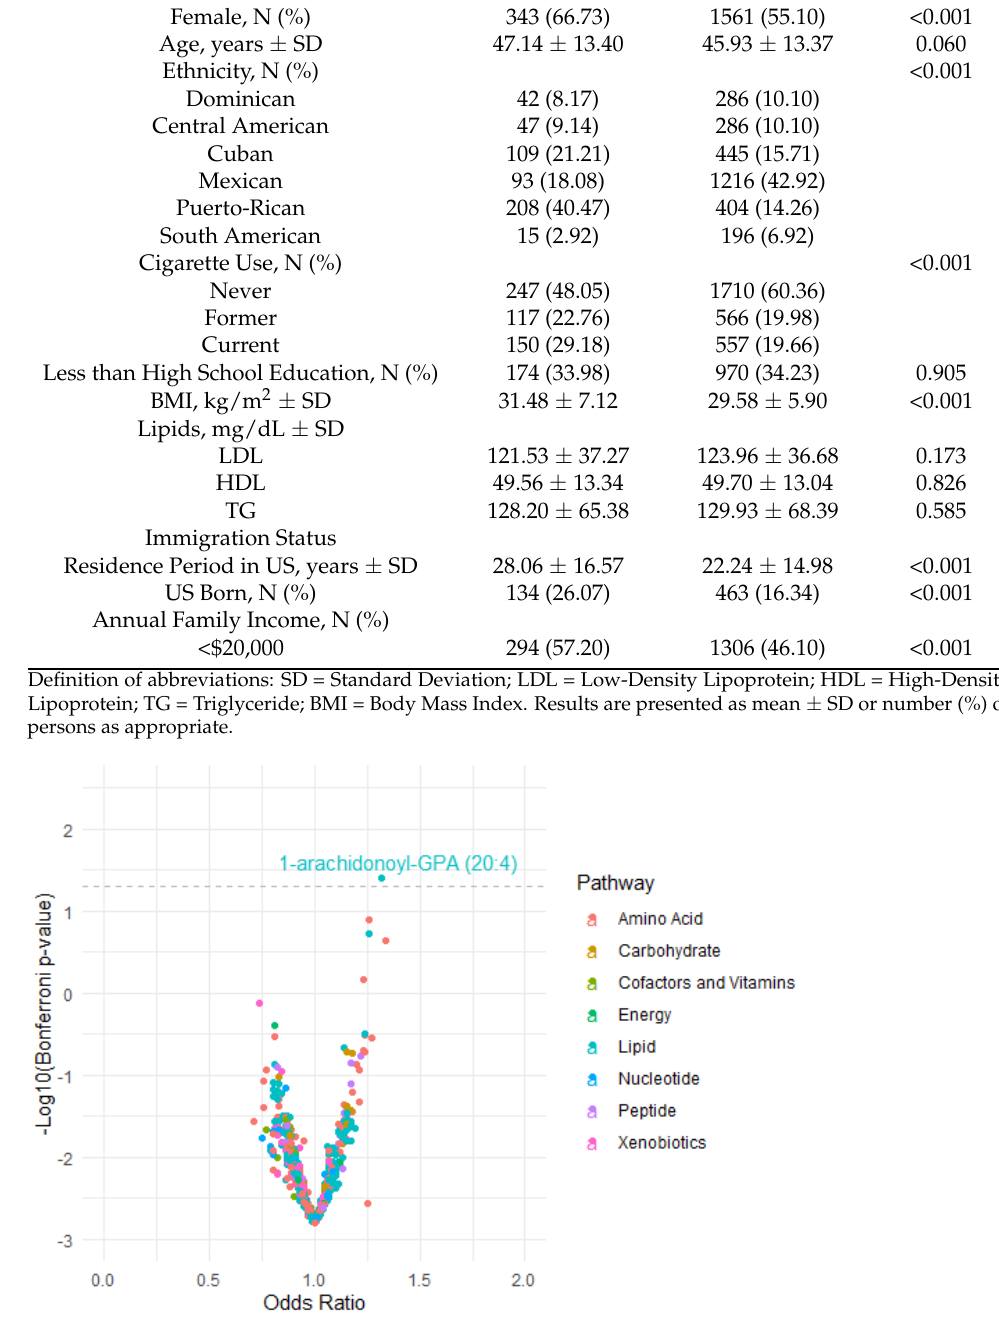
Figure 1. Volcano plot illustrating the relationship between 640 single metabolites and asthma. The odds ratios were calculated from survey logistic regressions adjusting for age, sex, immigration status, field centers, years of living in the U.S., Hispanic and/or Latino backgrounds, low-density lipoprotein cholesterol (LDL), high-density lipoprotein cholesterol (HDL), triglycerides (TG), smoking, education level, and household income. x -axis: odds ratio between each metabolite level and asthma status; y -axis: − log 10 (Bonferroni adjusted p -value) for each metabolite with the dashed line ( − log 10 0.05 = 1.301) representing the significance threshold.